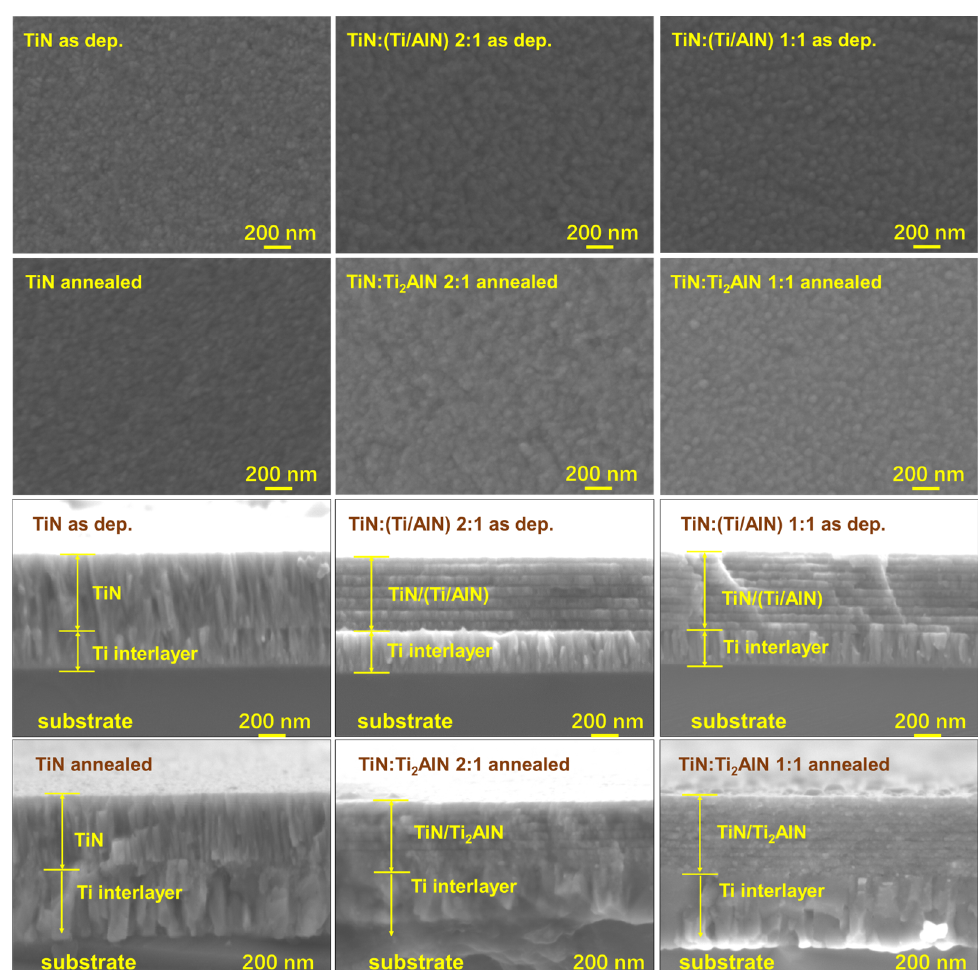
Figure 3. Surface and cross-section SEM image of the TiN, TiN/(Ti/AlN), and TiN/Ti 2 AlN multilayers.